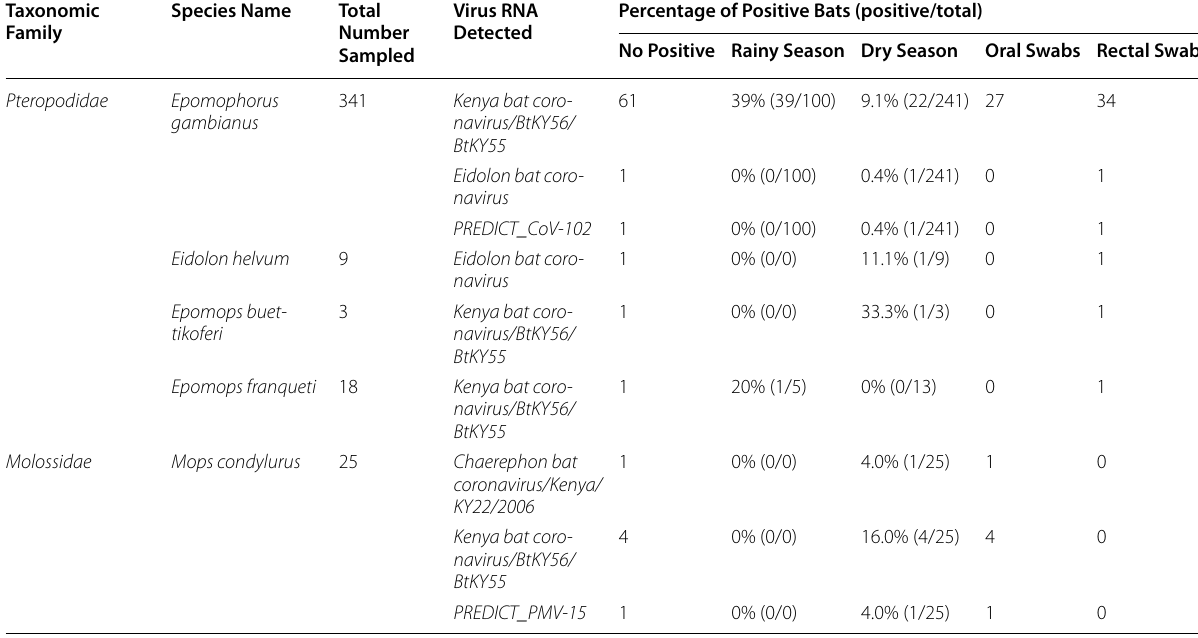
Table 1 Number and percentage of bats testing positive for viral RNA in the Boabeng‑Fiema area in Ghana, from February 2017 – December 2018. Results are presented by bat species with RNA positive samples, season (dry/rainy), and specimen type (oral/rectal swabs). Bats were tested for five viral families with pandemic potential (coronaviruses, paramyxoviruses, flaviviruses, influenza viruses, and filoviruses)